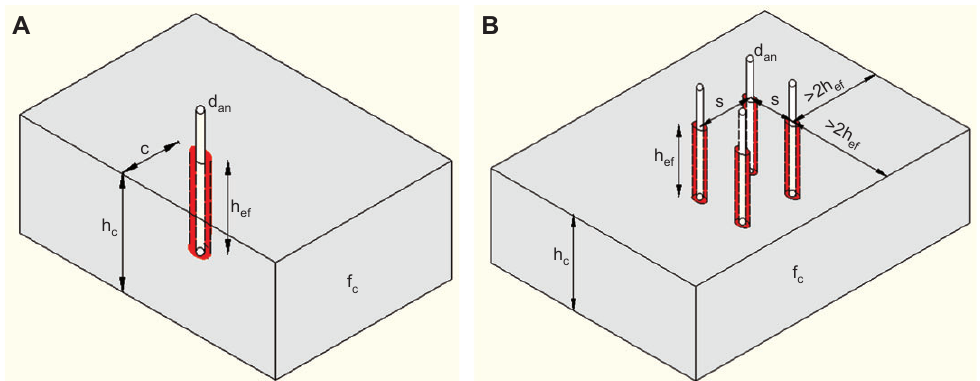
Figure 1 Characteristics of single and group anchors. (A) Single anchor (located near a concrete edge). (B) Group anchors